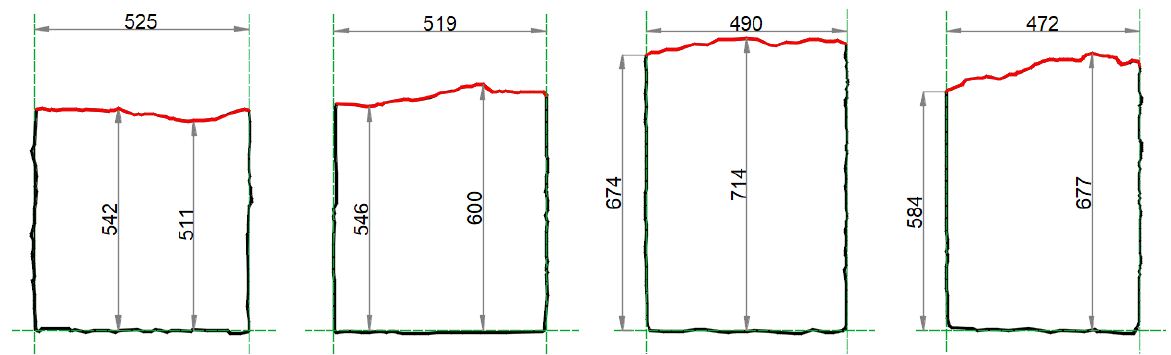
Figure 7. End fragments after beam failure: Beams 1 – 4 (from left to right ). Sizes are given in mm, and the separating crack is presented with red color.